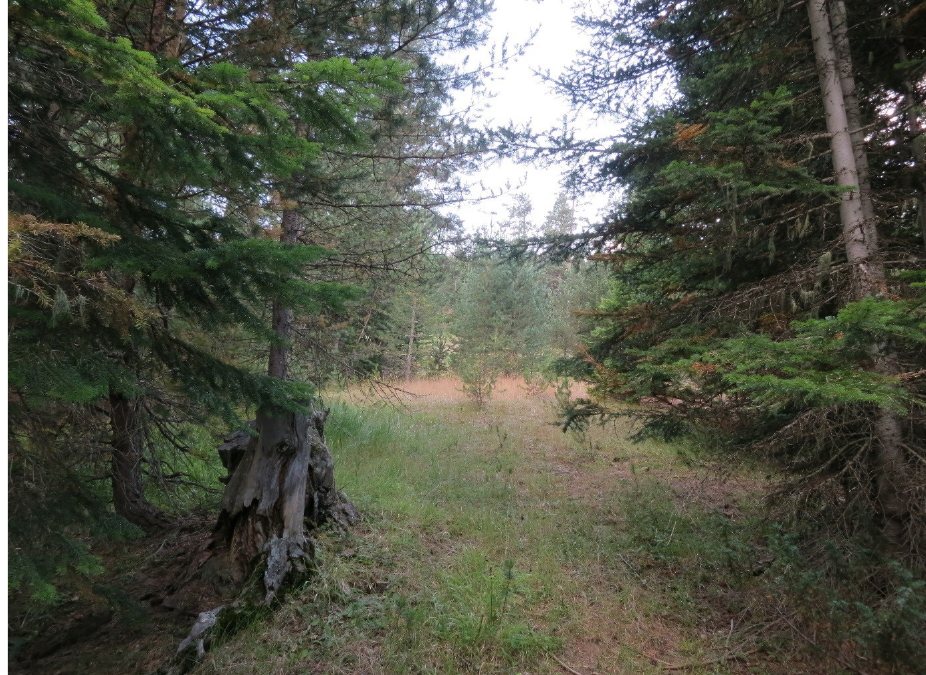
Fig 2 . Collecting site of Arıkmusa Village, Turkey, where the inquiline ant Leptothorax kutteri was found in a nest of Leptothorax